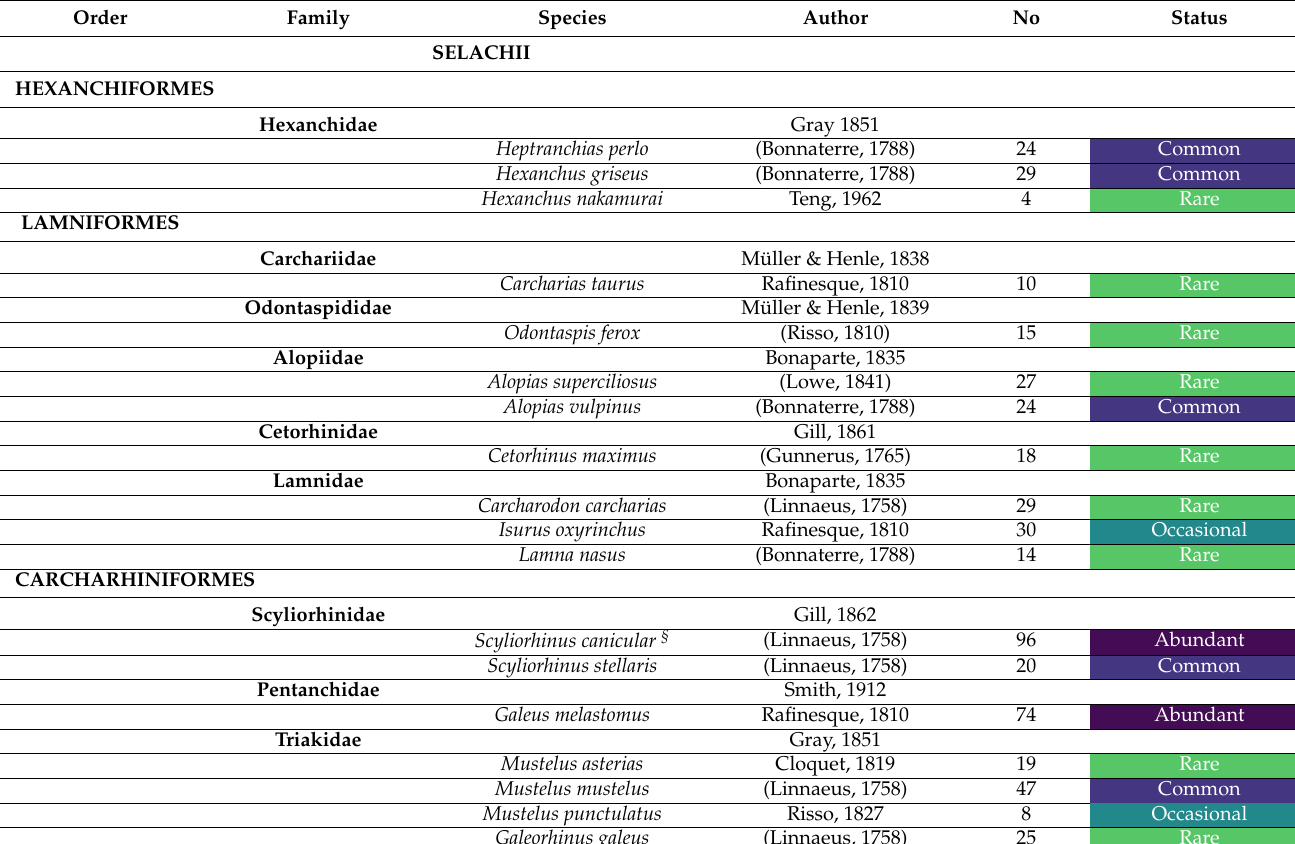
Table 1. Number of sources presenting observations of the chondrichthyan species in Greece in available sources since 1990. No is the number of sources. Definitions are presented in Section